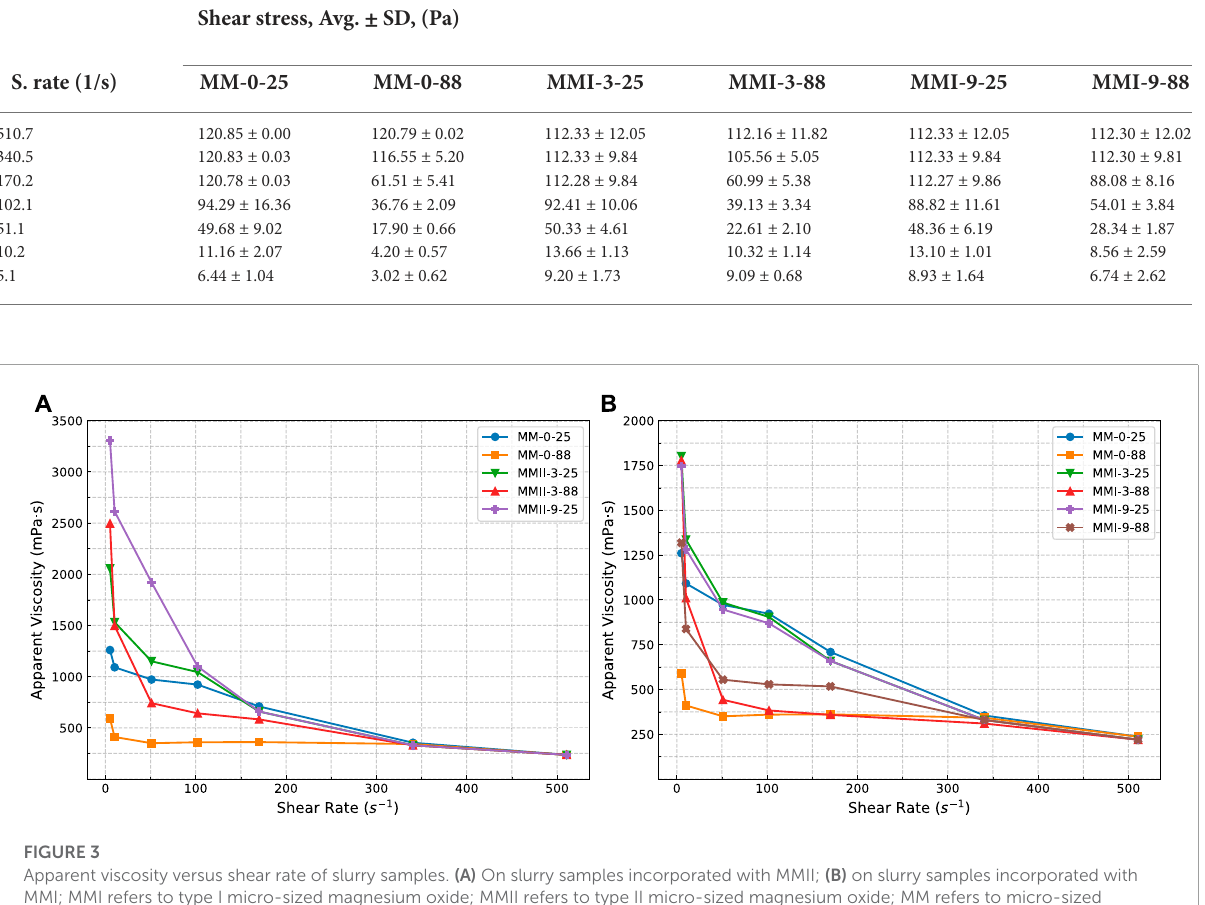
TABLE 4 Shearstressvs.differentshearrateswithitsstandarddeviationofthecontrolslurryandMMIslurrysamples. Shear stress, Avg. ± SD, (Pa)